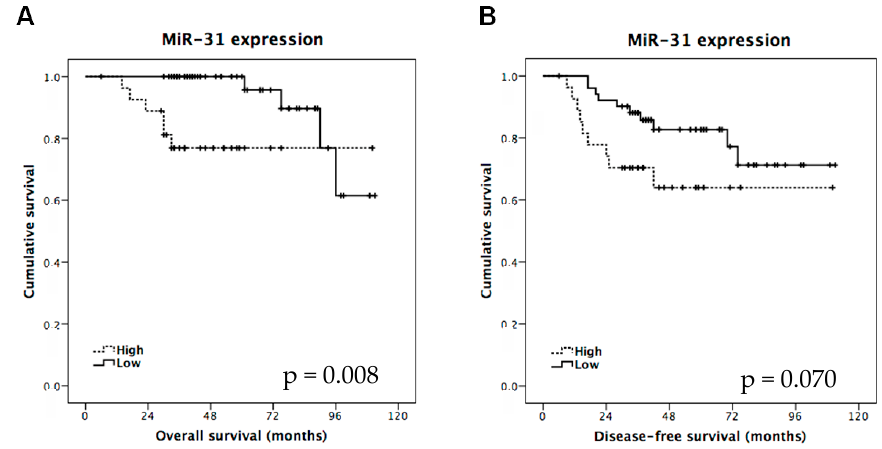
Figure 3. Kaplan-Meier analysis of ( A ) overall survival (OS) and ( B ) disease-free survival (DFS) in LARC patients based upon miR-31 expression in primary tumors measured prior to the neoadjuvant treatment. Table 4. LARC patients factors predictive of poor overall survival: Univariate and multivariable analyses. Univariate Variables